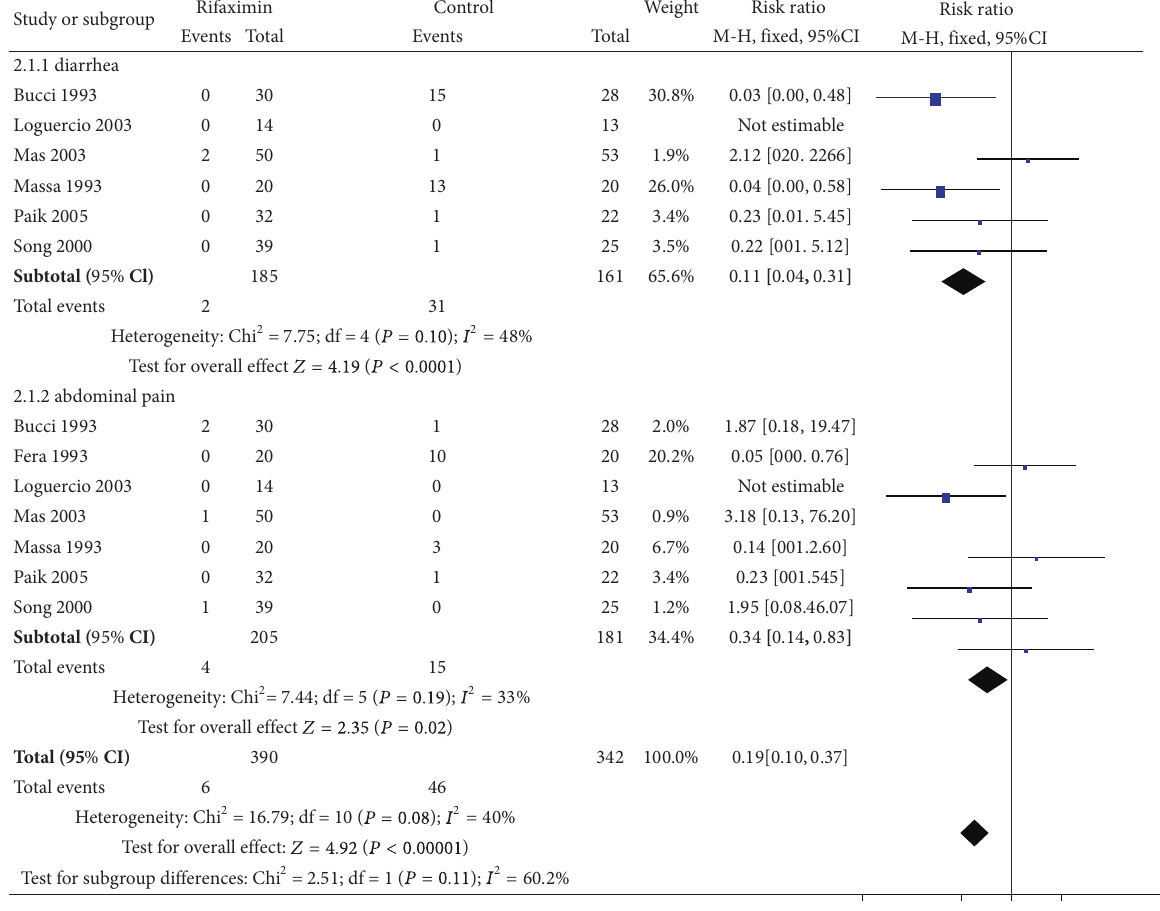
Study or subgroup